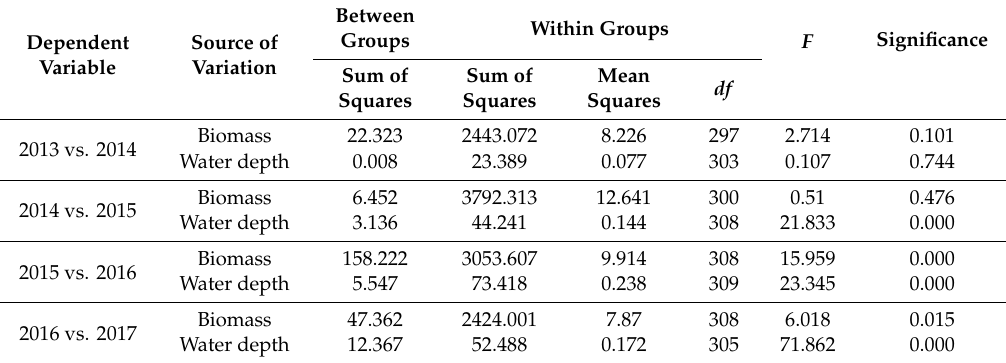
Table 1. Statistical analysis of the e ff ect of water depth on aquatic vegetation biomass.